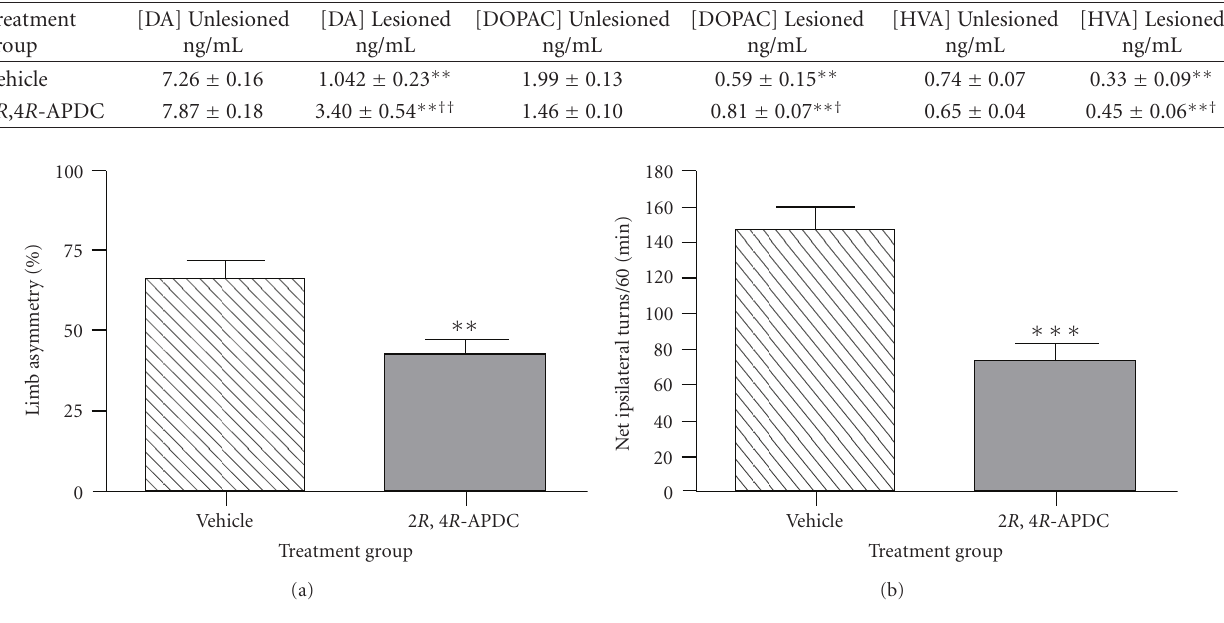
Figure 2: Neuroprotection against 6-OHDA toxicity following delayed subchronic intranigral administration of 2 R ,4 R -APDC (10nmol in 4 μ L) translates into functional recovery of motor deficits. (a) Bar graph of mean percentage forelimb use asymmetry ± s.e.m in vehicle and 2 R ,4 R -APDC (10nmol)-treated animals, ∗∗ P < 0 . 01, vehicle versus 2 R ,4 R -APDC. (b) Bar graph of amphetamine-induced rotational behavior, expressed as net ipsilateral turns over 60 minutes ± s.e.m in vehicle and 2 R ,4 R -APDC-treated animals, ∗∗∗ P < . 001, vehicle versus 2 R ,4 R -APDC.